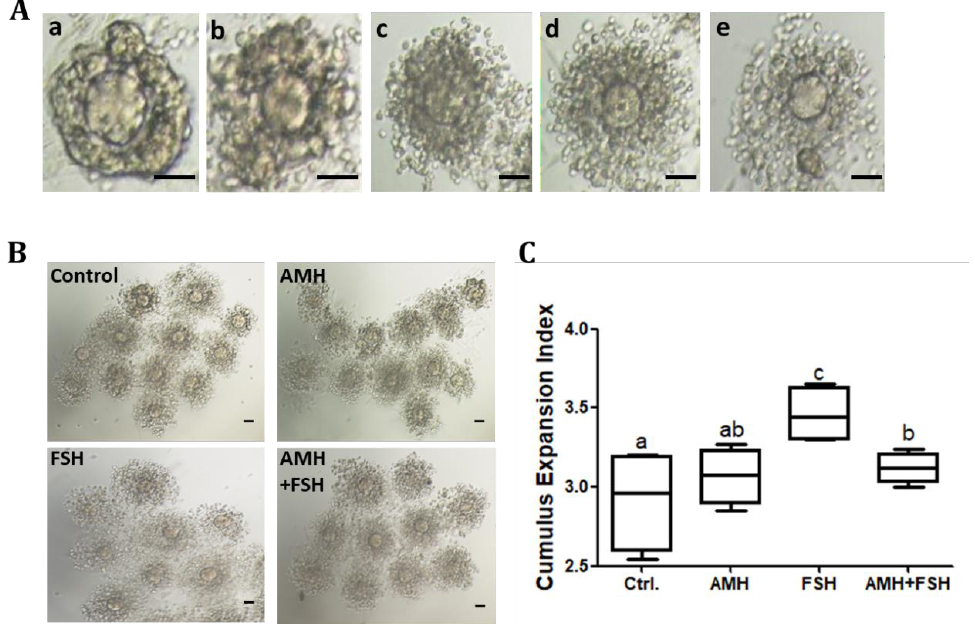
Figure 3. Effect of rhAMH on cumulus cell expansion. COCs were supplemented with AMH and FSH alone or in combination for 16 h, cumulus cell expansion was analyzed by the cumulus expansion index (CEI). ( A ), representative images of different grades of cumulus cell expansion, a = 0, b = 1, c = 2, d = 3, e = 4, the scale bar represents 50 µ m. ( B ), the representative cumulus cell expansion of each group, the scale bar represents 50 µ m. ( C ), the CEI of each group. Data were from at least three independent experiments. Bars with different letters represent significant differences ( p < 0.05).